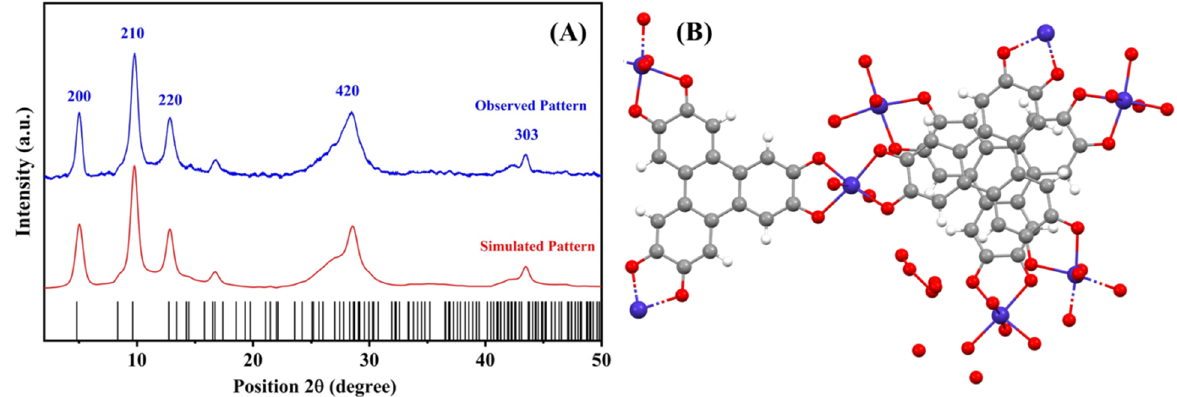
Figure 2. ( A ) PXRD pattern of the observed and simulated Cu-MOF powder, ( B ) Structural information of the 2D Cu-MOF.